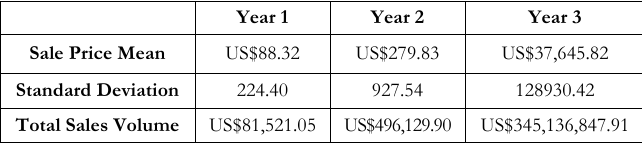
Table 2: Average Annual Sale Price and Sales